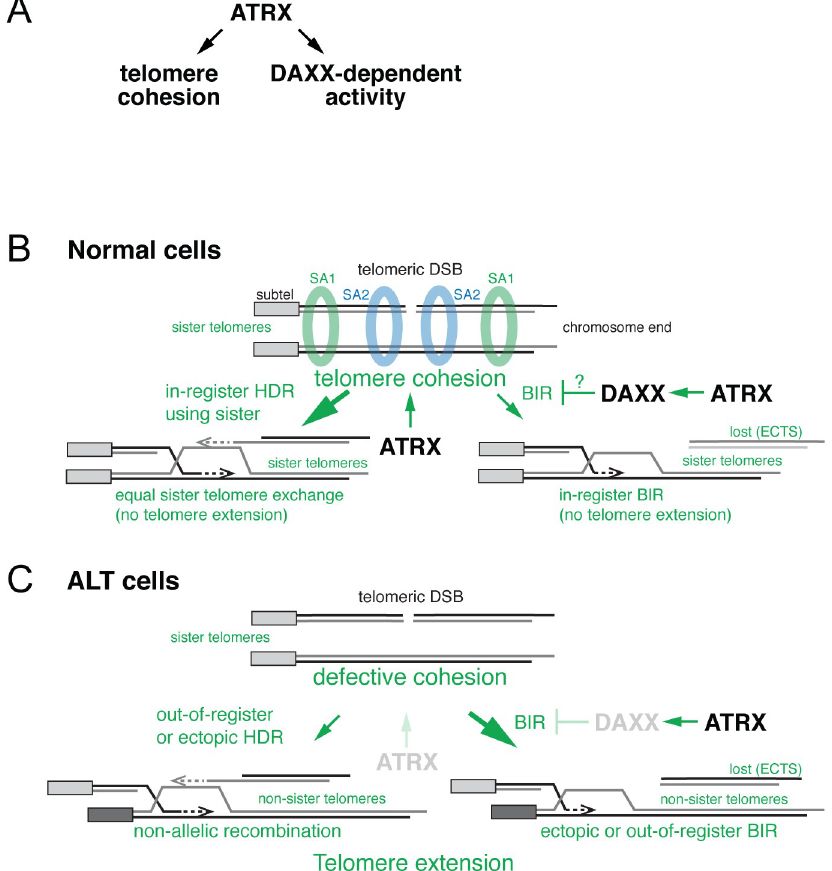
Fig 7. Model for how loss of ATRX promotes ALT. (A) Proposed role for ATRX in repressing ALT through telomere cohesion and a DAXX-mediated activity. (B) Repair of telomeric DSBs in cells with intact ATRX and DAXX. Telomere cohesion is established during replication in an SA1-dependent manner and at a DSB by SA2-dependent cohesion. The close proximity and proper alignment of the chromatids by cohesin favors use of the sister telomere for DSB repair and ensures that repair results in equal sister telomere exchange or BIR using the sister telomere in-register, thus providing no mechanism for telomere extension. (C) ATRX loss changes telomeric DSB repair and promotes ALT through two separate pathways. First, the disruption of ATRX-mediated telomere cohesion allows unequal sister telomere recombination and the use of nonallelic telomeres for DSB repair. These types of interactions are necessary for telomere elongation and are consistent with the recombination events observed in ALT cells. Second, disruption of a DAXX- dependent function of ATRX is proposed to change the repair outcomes of telomeric DSBs, promoting BIR over other DSB repair pathways. ALT, alternative lengthening of telomeres; ATRX, alpha thalassemia/mental retardation syndrome X-linked chromatin remodeler; BIR, break-induced replication; DAXX, death domain-associated protein; DSB, double-strand break; HDR, homology-directed repair; SA1, stromal antigen 1; SA2, stromal antigen